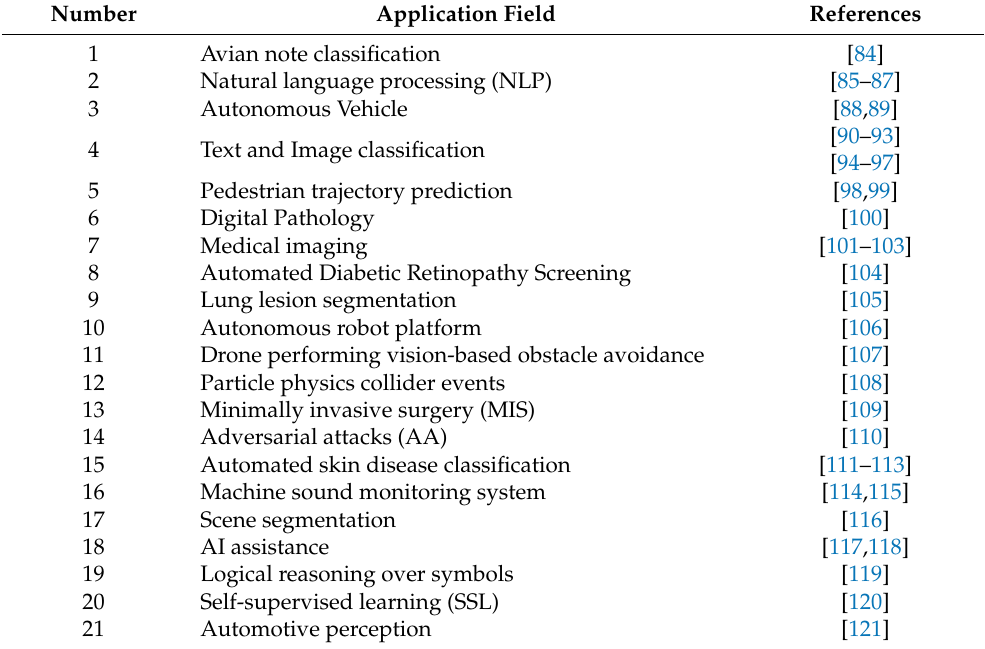
Table 2. Application Summary